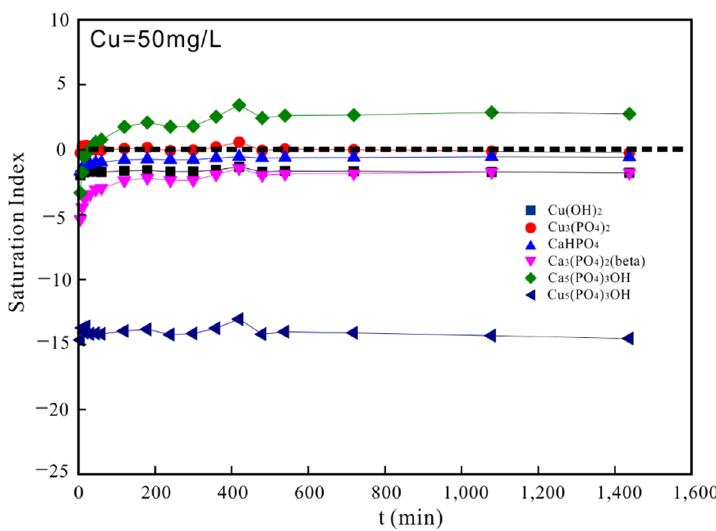
Figure 15. Saturation index with respect to the minerals containing Cu and Ca during Cu (II) removal by SC–HA/C (25 °C; pH 5.0; initial concentration 10~50 mg/L; SC–HA/C dose 0.5 g/50 mL).